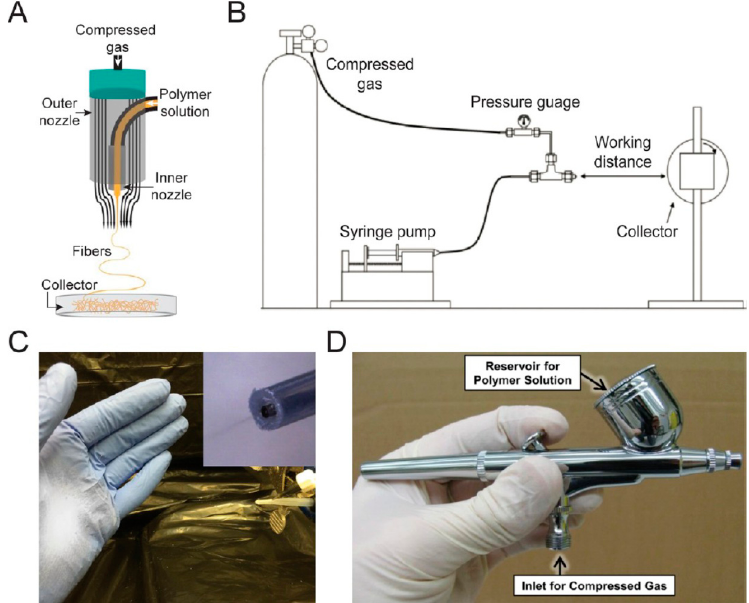
Figure 5. Various parts of SBS setup [29]: ( A ) Inlets for polymer solution and air with fibers coming out of nozzle due to attenuation force applied by high speed air [43]. ( B ) Schematic of SBS setup [44]. ( C ) Image of direct deposition of poly(styrene-block-isoprene-block-styrene) block copolymer fibers using a homemade solution blow spinning device [43]. ( D ) Commercial airbrush used for solution blow spinning [45].